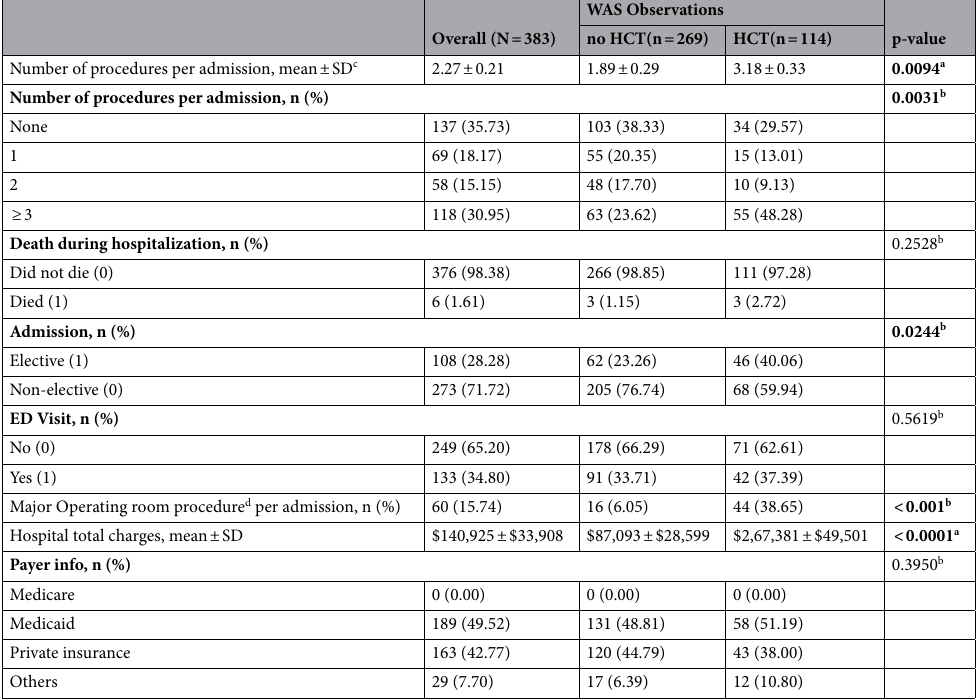
Table 2. Hospitalization characteristics of Wiskott-Aldrich syndrome patients in HCUP kids database. HCT – Hematopoietic stem cell transplantation, SD – Standard Deviation. a Two-tailed independent sample t-test. b Rao-Scott adjustment for chi-square test. c Including line placement, lumbar punctures, bone marrow biopsies. d Included line placements, bone marrow biopsies, other surgical procedures, endoscopies.